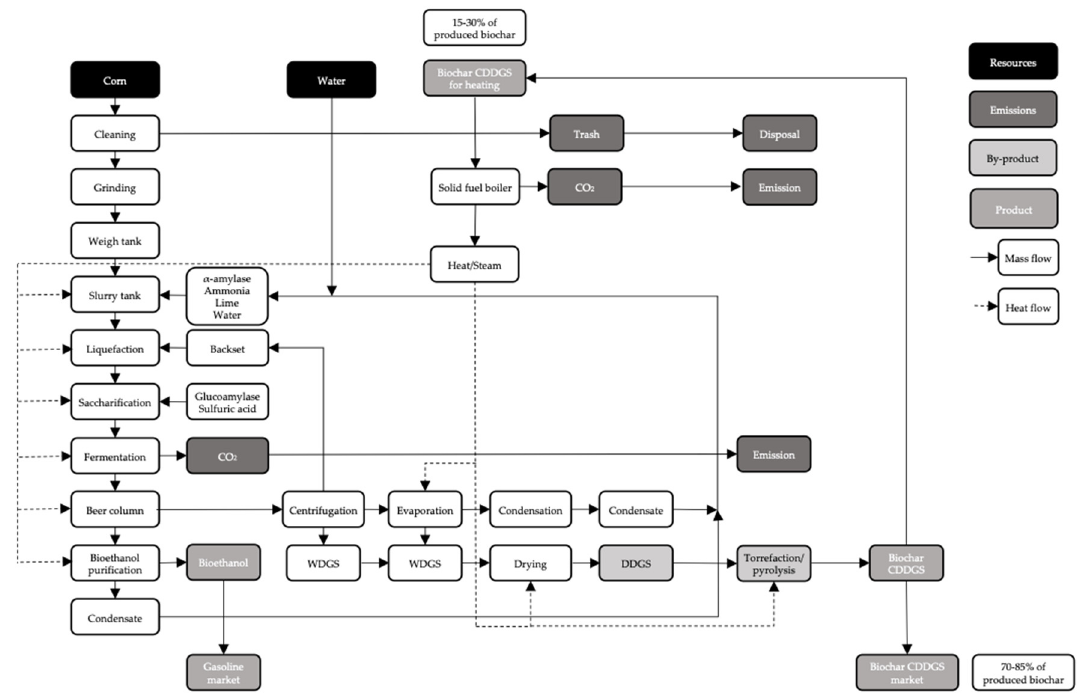
Figure 4. A detailed breakdown of the processes in the proposed ethanol production system.